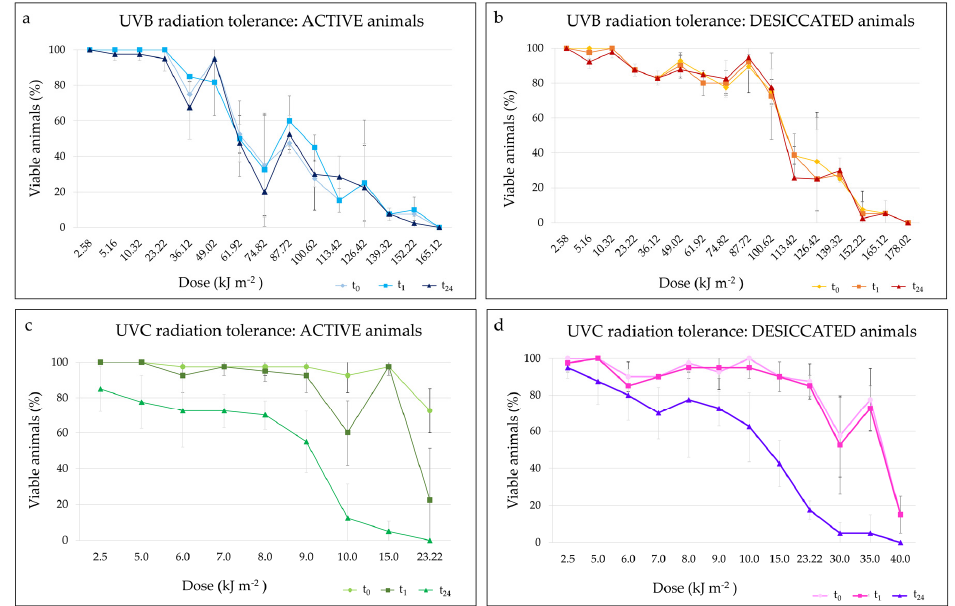
Figure 8. UVB and UVC tolerance of M. kyoukenus sp. nov.: percentage of viable animals after exposure to increasing doses of UV radiation; ( a ) Active animals after exposition to UVB radiation. ( b ) Desiccated animals after exposition to UVB radiation; ( c ) Active animals after exposition to UVC radiation; ( d ) Desiccated animals after exposition to UVC radiation. ( a , c ) The locomotion performances of animals evaluated immediately after the end of the irradiation (t 0 ), after 1 h (t 1 ) and 24 h (t 24 ) are reported. ( b , d ) The locomotion performances of animals evaluated after the end of rehydration (t 0 ), after 1 h (t 1 ) and 24 h (t 24 ) are reported. ( a – d ) For each tested UV dose, the mean percentage of viable animals and its standard deviation are